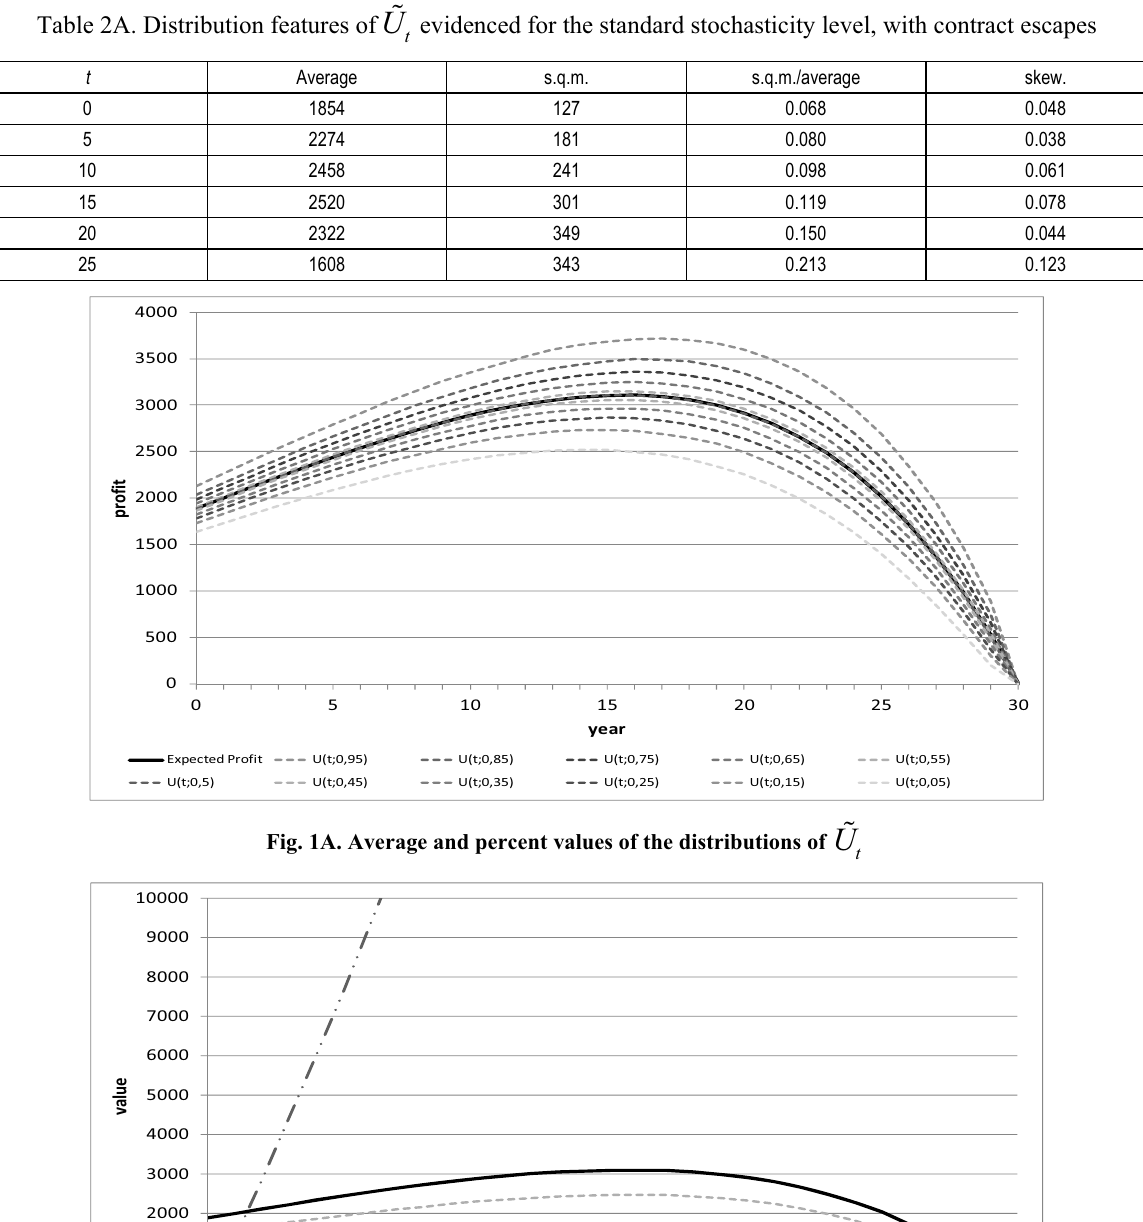
Table 2A. Distribution features of